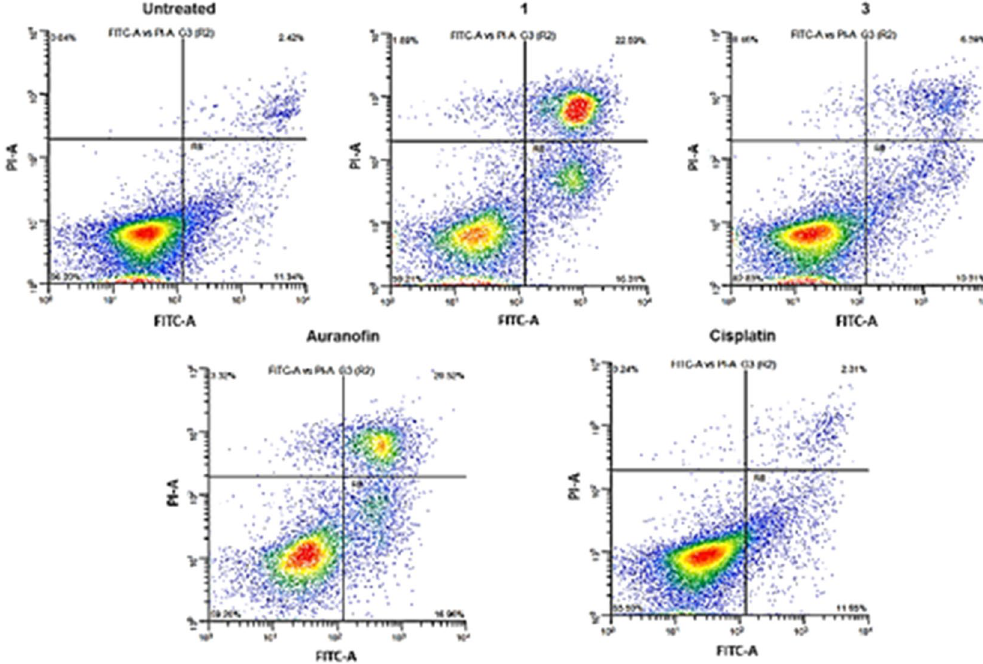
Figure 9. FITC Annexin V/PI apoptosis dead cell assay. OVCAR8 cells were used. Plots of untreated cells (negative control), cells treated with 1 (2 μ M for 48 h), 3 (2 μ M for 48 h), auranofin (2 μ M for 48 h), or cisplatin (2 μ M for 48